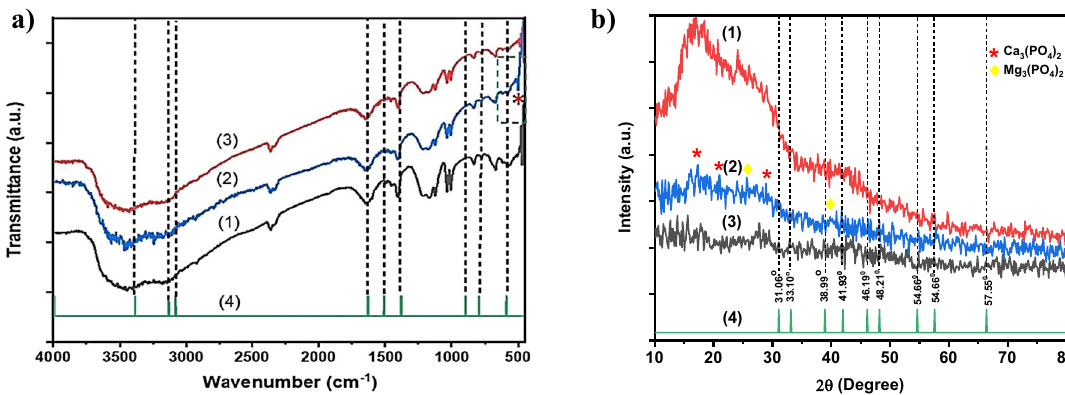
Fig. 1 FTIR spectra and XRD patterns of materials. a FTIR spectra of (1) 225H, (2) HIAO/225H after phosphate adsorption, (3) fresh HIAO/ 225H, (4) lepidocrocite and goethite references 48,49 . b XRD patterns of (1) 225H, (2) HIAO/225H after phosphate adsorption, (3) fresh HIAO/ 225H, and (4) iron oxide-hydroxide reference (JCPDS card no. 18-0639) 54